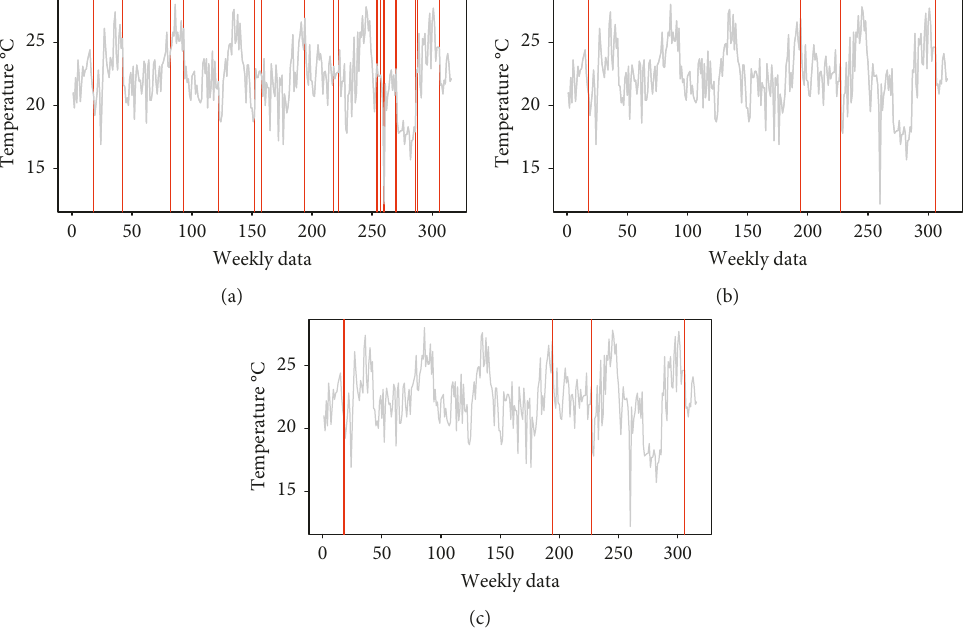
Figure 8: Location of change points for the variance of maximum temperature. (a) PELT method. (b) SN method. (c) BS